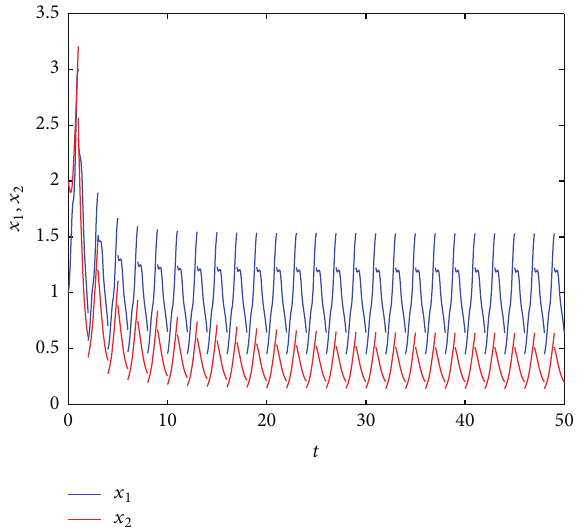
Figure 2: Dynamical behavior of system (73). Obviously, species 𝑥 1 and 𝑥 2 are permanent and 2 -periodic. Here, we take initial values = 1 and 𝑥 = 2 𝑥 10 20